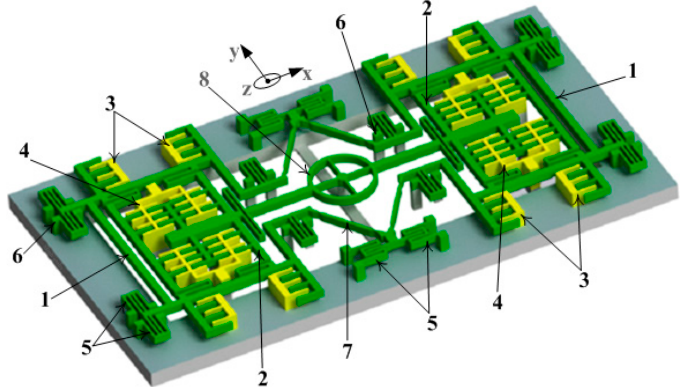
Figure 1. Schematic drawing of the proposed freestanding tuning fork gyroscope: (1) outer frame, (2) inner frame, (3) driving comb electrodes, (4) parallel plate sense electrode, (5) double folded beams, (6) anchors, (7) linear beams and (8) self-rotation ring.